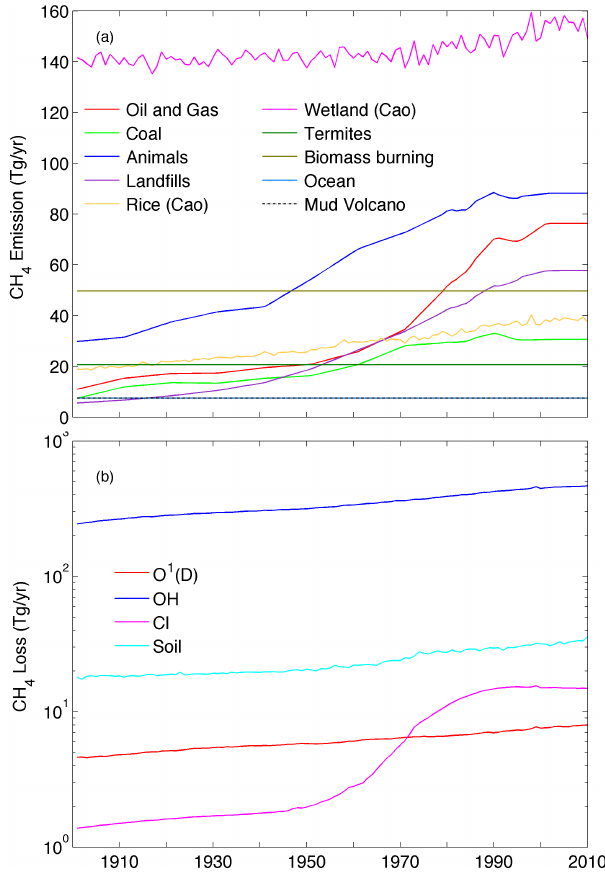
Figure 1. (a) Time series of CH 4 emission inventory estimates from different categories during our simulation. (b) Chemical loss of CH 4 calculated using ACTM simulation with initial emissions ( E ini